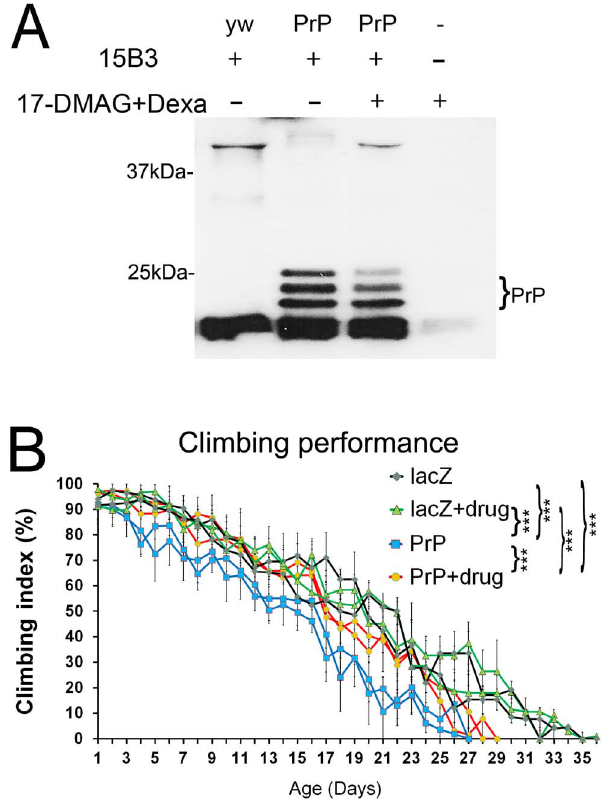
Figure 4. Co-treatment of 17-DMAG and dexamethasone perturbs the accumulation of pathogenic PrP isoforms and improves locomotor dysfunction. A , Flies expressing PrP ubiqui- tously (da . PrP-M6) were fed with 17-DMAG (96 m g/ml) and dexameth- asone (24 m g/ml) during development and aged with the drugs for 30 days. Then, we subjected 30 day-old flies to immunoprecipitation with the 15B3 antibody and revealed PrP levels by western blotting. A control experiment with non-PrP flies (yw, lane 1) yielded only non- specific signal from antibody fragments. Flies expressing PrP accumu- lated 15B3-positive isoforms (lane 2), but when treated with the drug cocktail, less PrP was recognized by 15B3 (lane 3). A control experiment without fly homogenate or 15B3 produced no signal (lane 4). B , Climbing ability of adult females expressing LacZ or PrP-M9 in motor neurons with or without the drug cocktail. Non-treated flies expressing PrP in motor neurons (blue lines) induced locomotor dysfunction compared to LacZ flies (black line). PrP flies treated with the drugs (red line) performed significantly better than the non-treated flies. Statistical significance was analyzed by ANOVA multiple comparisons: ** p , 0.01; *** p , 0.001.